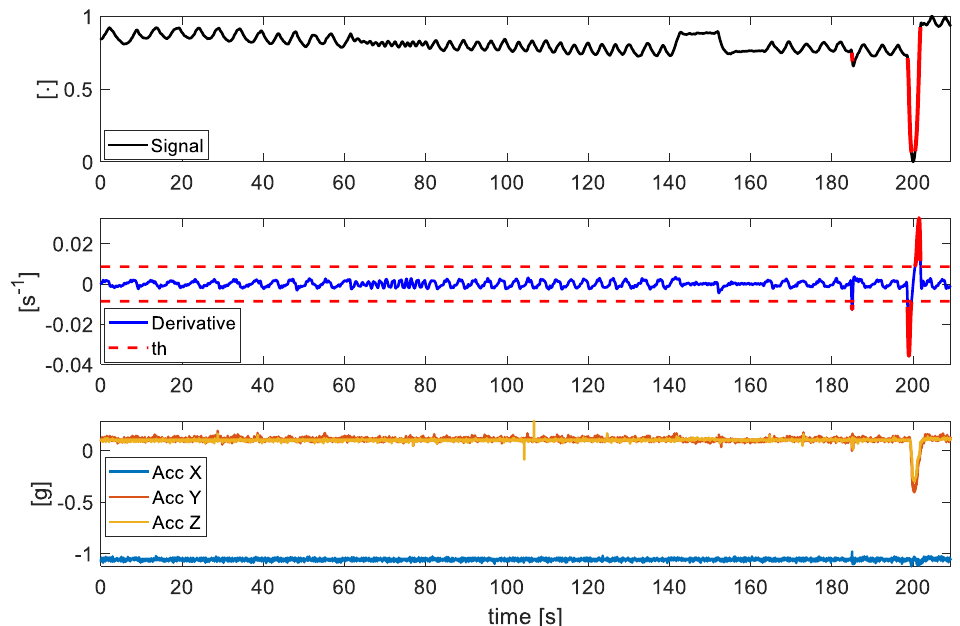
Figure 4. In the first subplot, an exemplary signal extracted by the FO method from a video; in the second subplot the derivative of this signal and the th represented as red dashed lines; in the third subplot the X , Y , and Z axis of the accelerometer inside the BH3 (see Figure 1B) used as reference of the breathing-unrelated events. In red, the artefacts identified on the signal and